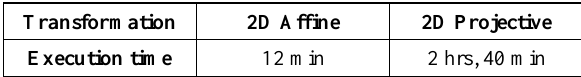
Table 17. The execution time of two kinds of